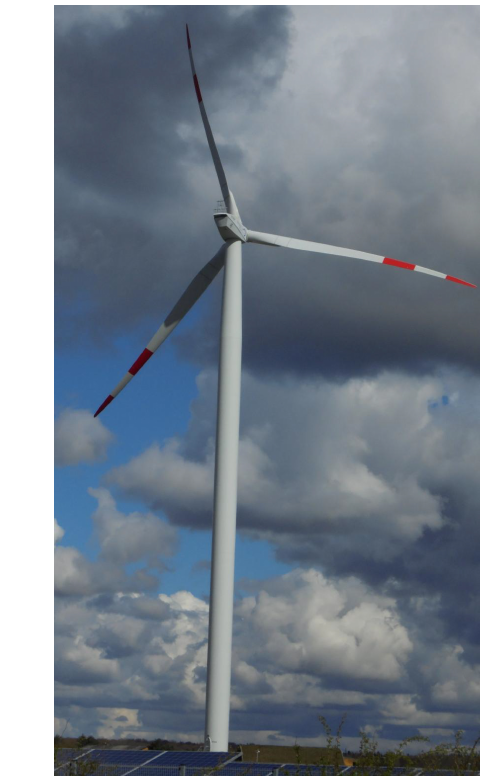
Figure 7. Research turbine REpower (SENVION) MM92 at Egge- bek, Germany.